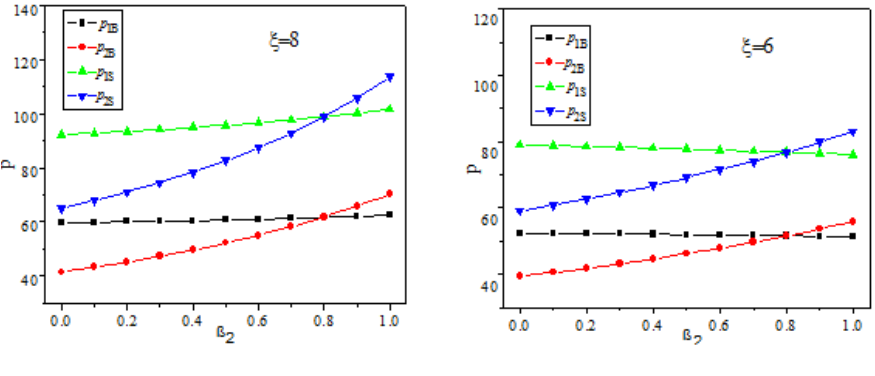
Figure 2. The change of the order quantity with the return price in two games